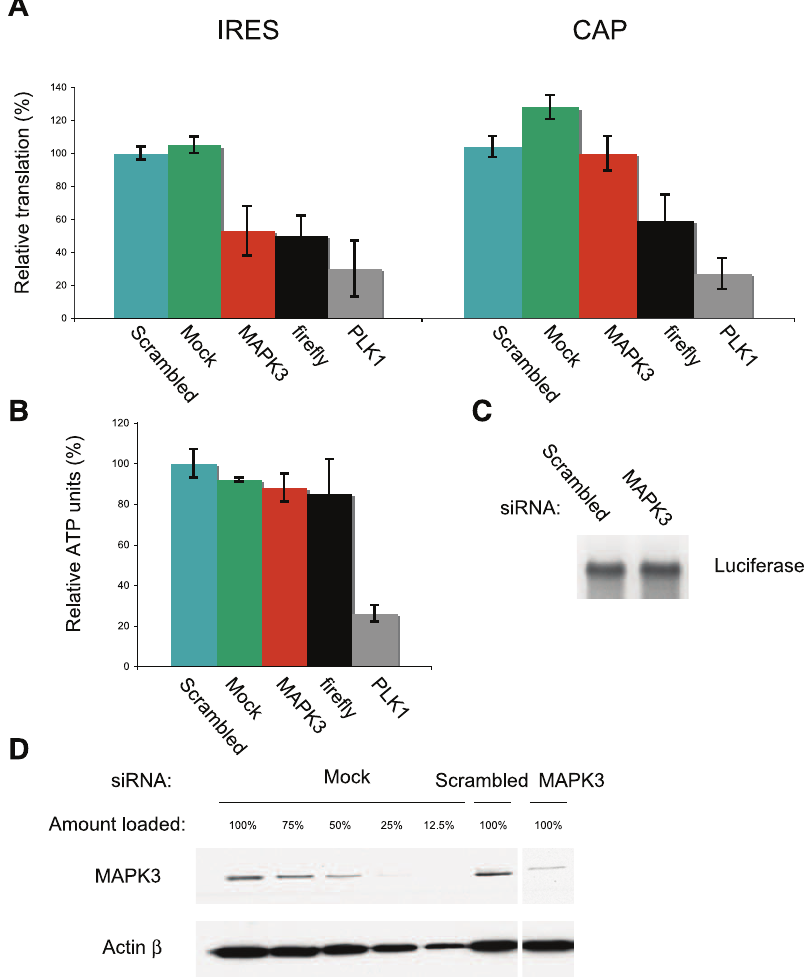
Figure 4. MAPK3 specifically regulates VEGF IRES-dependent translation. (a) HeLa cells were reverse transfected with the indicated siRNAs. This was followed 48 h later by reporter mRNA transfection for IRES-driven translation (left panel) and cap-driven translation (right panel). Luciferase activity was analyzed and the corresponding relative translation rate is indicated. (b) Quantification of ATP content as an indicator of cell viability. (c) Physical stability of the reporter VEGF IRES luciferase mRNA analyzed by Northern blotting. (d) Western blot of MAPK3 in siRNA-treated cells or control cells treated with scrambled siRNA. Beta-actin serves as a control for loading/transfer efficiency.